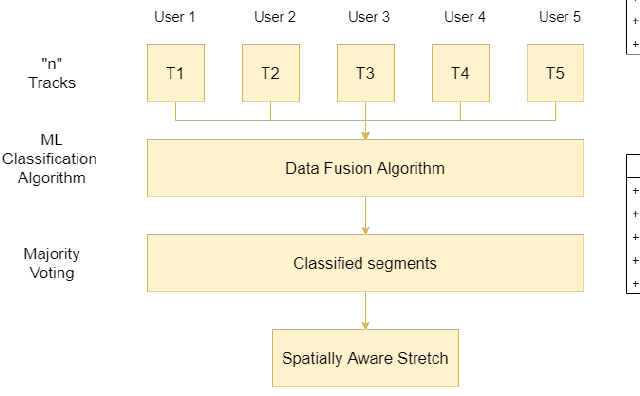
Figure 5. Data fusion